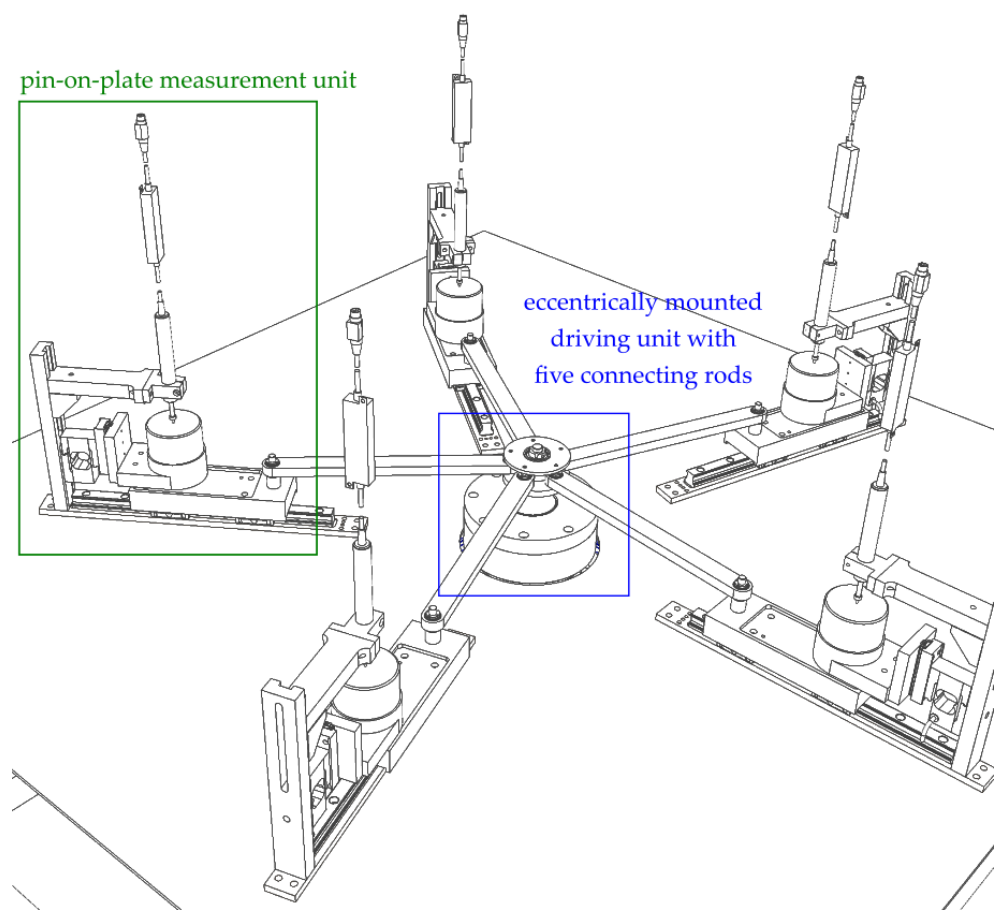
Figure 3. Quintuple reciprocating pin-on-plate tribo-tester with eccentrically mounted driving unit. J. Manuf. Mater. Process. 2020 , 4 , x FOR PEER REVIEW